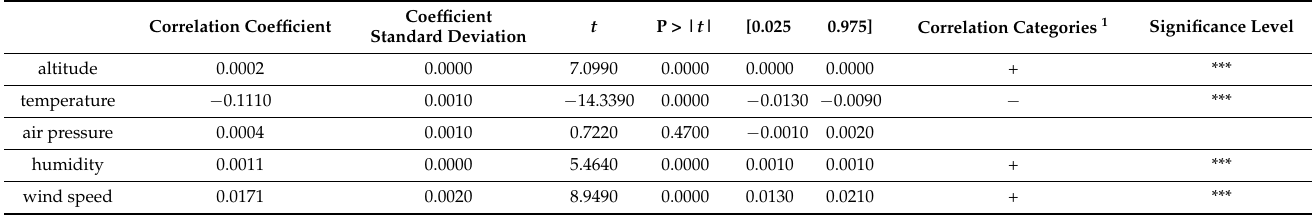
Table 1. The correlation performance of each feature when the dependent variable is average speed difference of